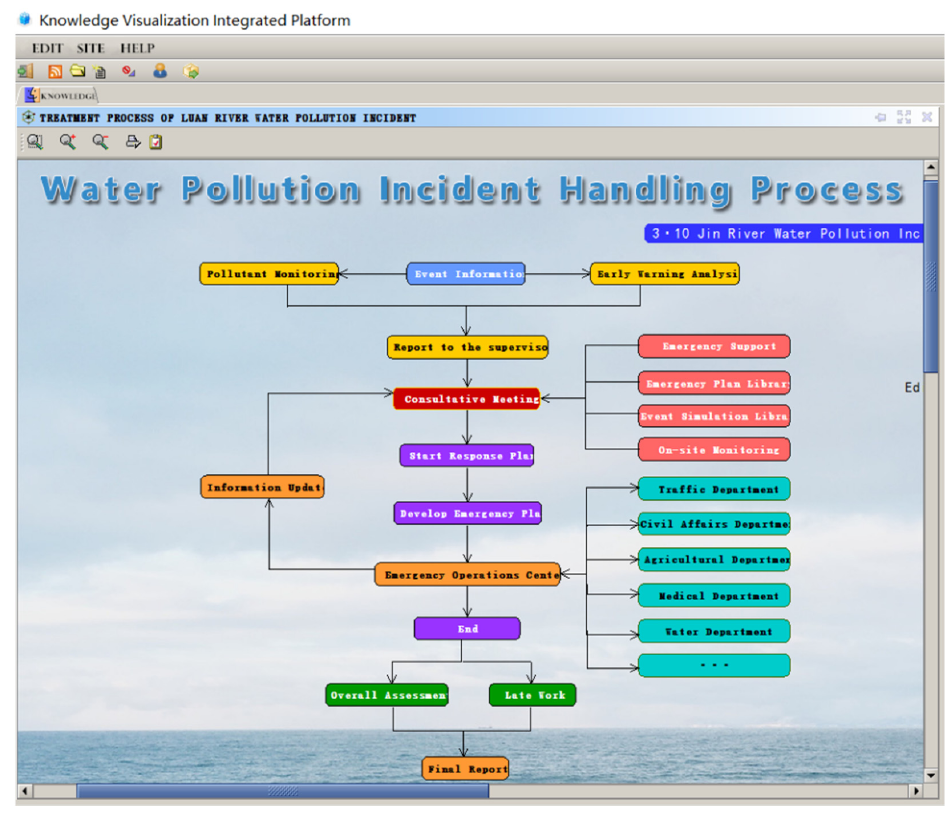
Figure 10. The main interface of the system.